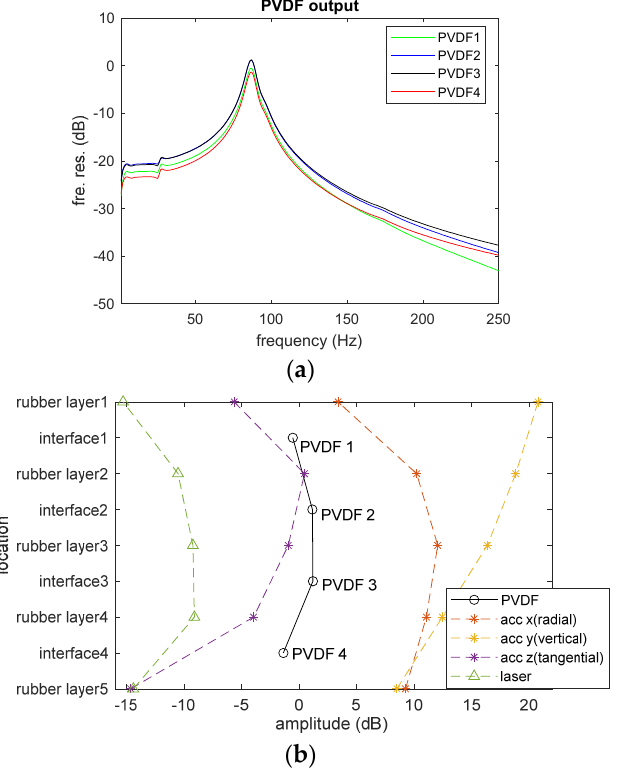
Figure 3. ( a ) The frequency responses of the embedded PVDF array and ( b ) output distribution of the sensors at 87 Hz.